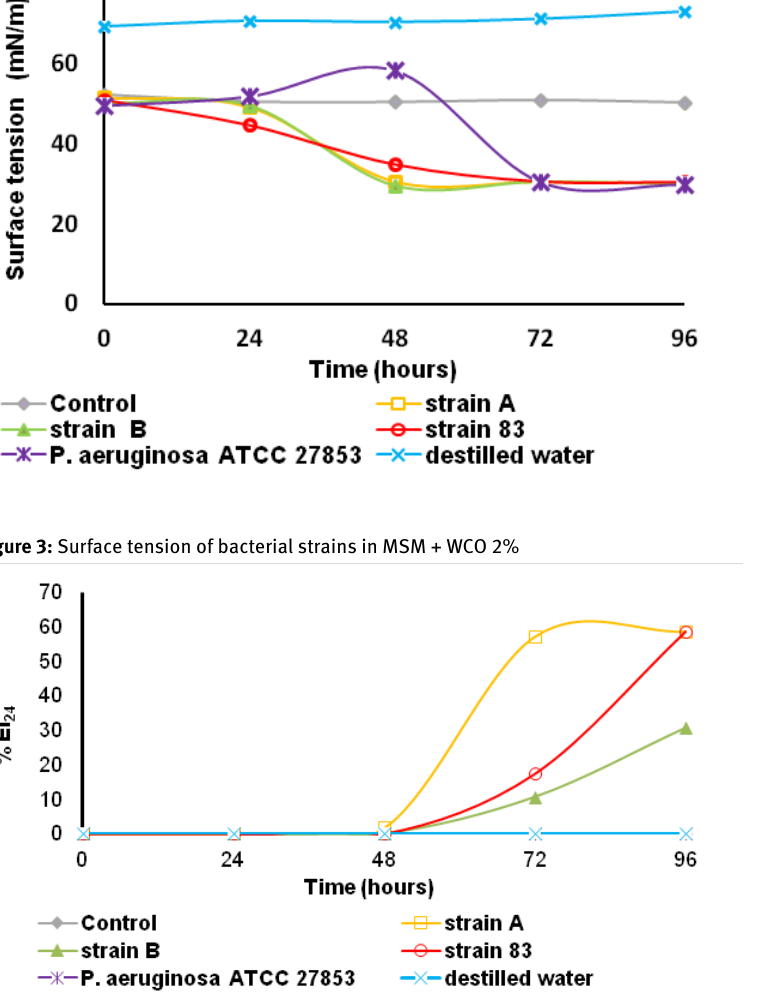
Figure 4: Emulsion Index from the strains cultured in MSM liquid and WCO